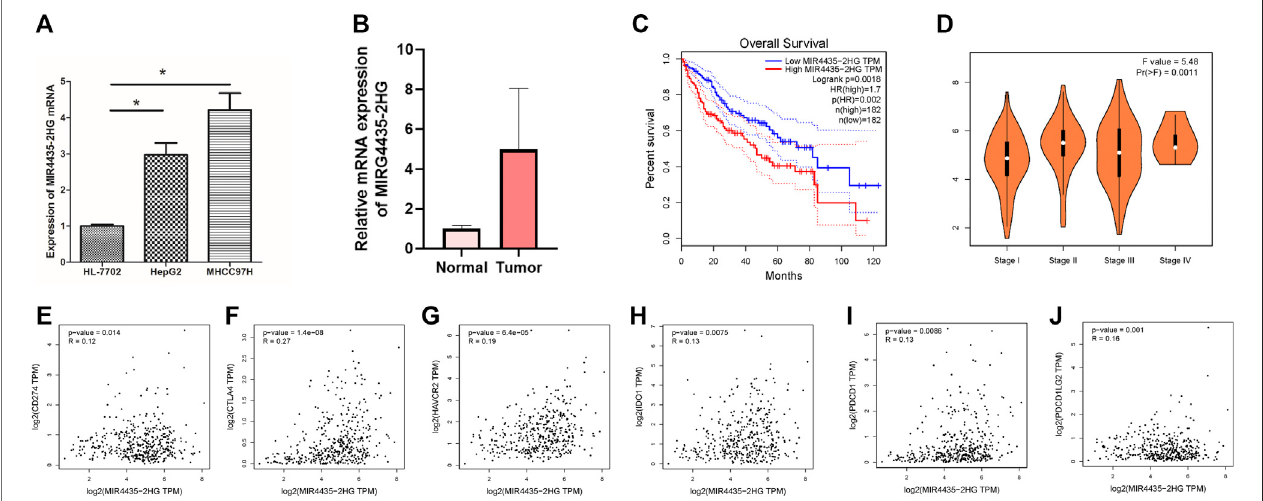
FIGURE 7 | High expression of MIR4435-2HG indicates poor prognosis. (A) . qPCR results indicate that MIR4435-2HG is highly expressed in HepG2 and MHCC97H cell lines, * p < 0.05. Each experiment is repeated at least three times. (B) qPCR results indicate that MIR4435-2HG is highly expressed in tumor tissue. (C) The prognosis ofsampleswithhighor lowexpression ofMIR4435-2HG issigni fi cantlydifferent. (D) Theexpression ofMIR4435-2HG hadsigni fi cantdifferencebetween major pathological stages. (E) The mRNA expression between MIR4435-2HG and CD274 had more similar pattern in HCC and normal tissues. (F) The mRNA expression between MIR4435-2HG and CTLA4 had more similar pattern in HCC and normal tissues. (G) The mRNA expression between MIR4435-2HG and HAVCR2 had more similar pattern in HCC and normal tissues. (H) The mRNA expression between MIR4435-2HG and IDO1 had more similar pattern in HCC and normal tissues. (I) The mRNA expression between MIR4435-2HG and PDCD1 had more similar pattern in HCC and normal tissues. (J) The mRNA expression between MIR4435-2HG and PDCD1LG2 had more similar pattern in HCC and normal